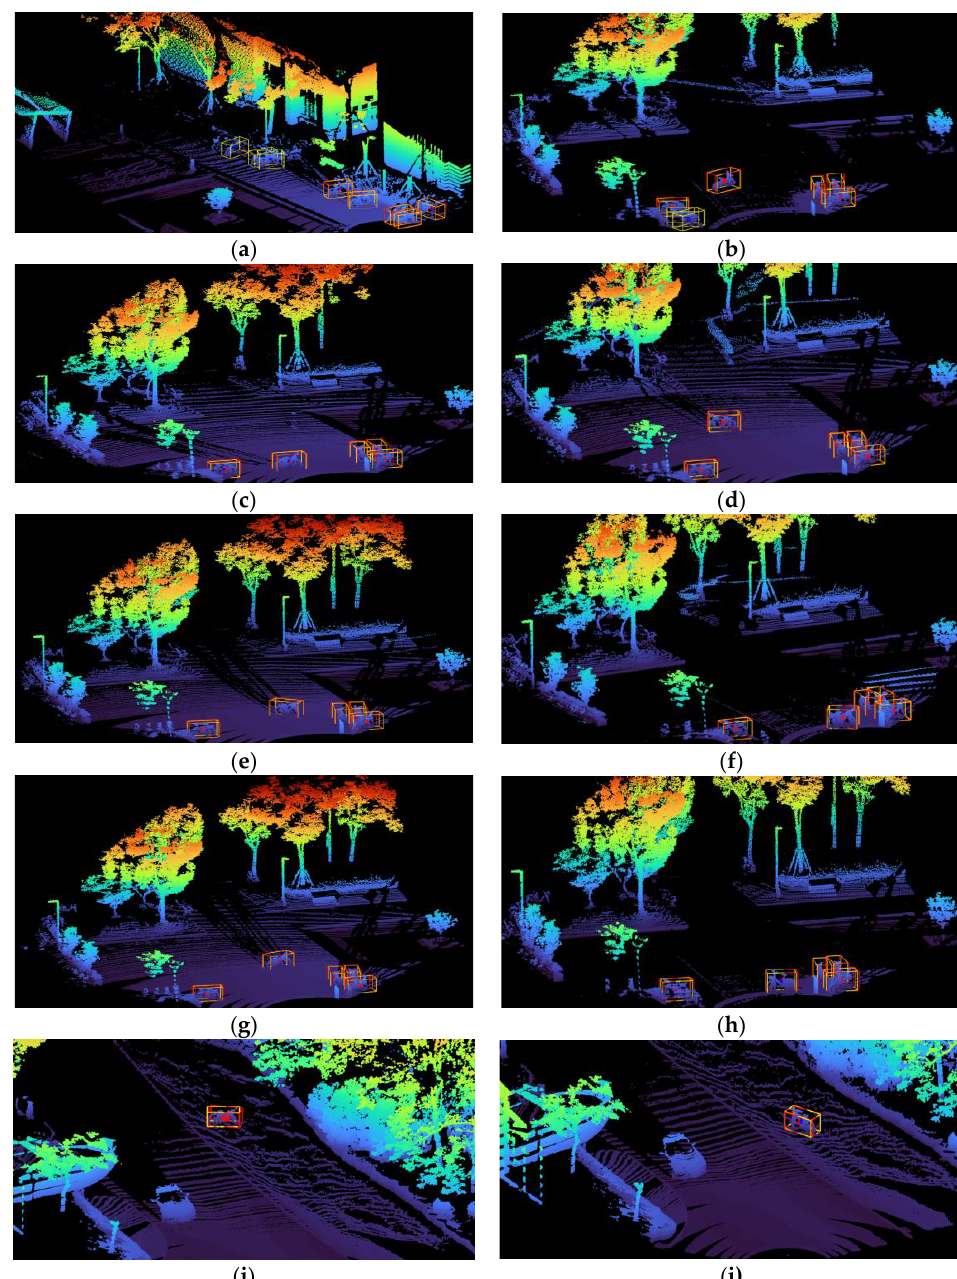
Figure 24. Localization results of the bikes. The yellow box is the ground truth of the bikes, and the red box is the results estimated by T-Net: ( a – j ) the corresponding localization results of ten scenes in Figure 21.